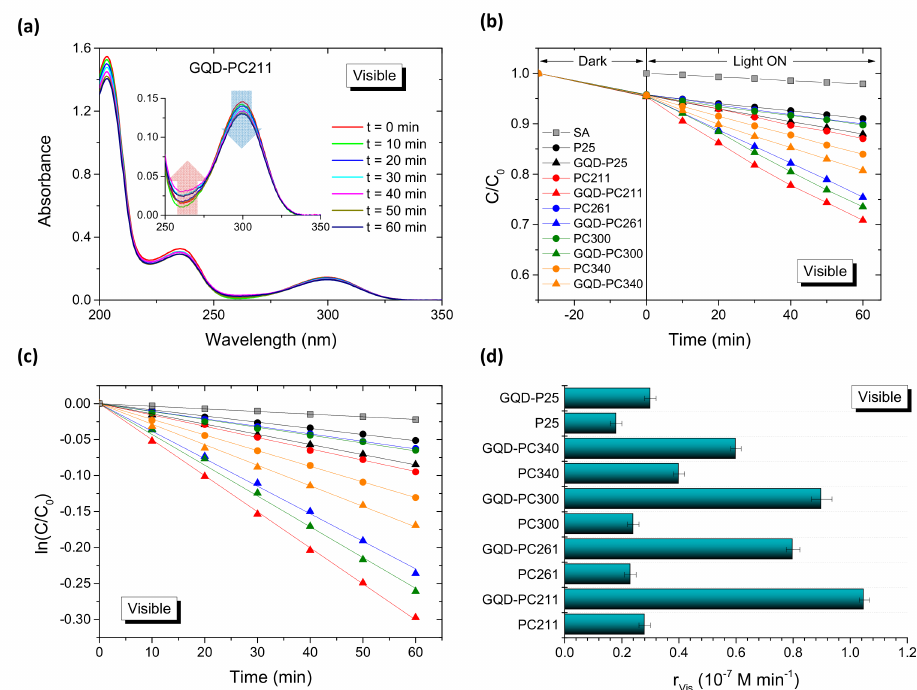
Figure 8. Salicylic acid (SA) ( a ) absorbance spectra, ( b , c ) photodegradation kinetics, and ( d ) reaction rates for the pristine and GQDs surface-modified PC and P25 TiO 2 films under visible light irradiation. Solid lines in ( c ) correspond to the best fit curves of the ln( C / C 0 ) vs. t